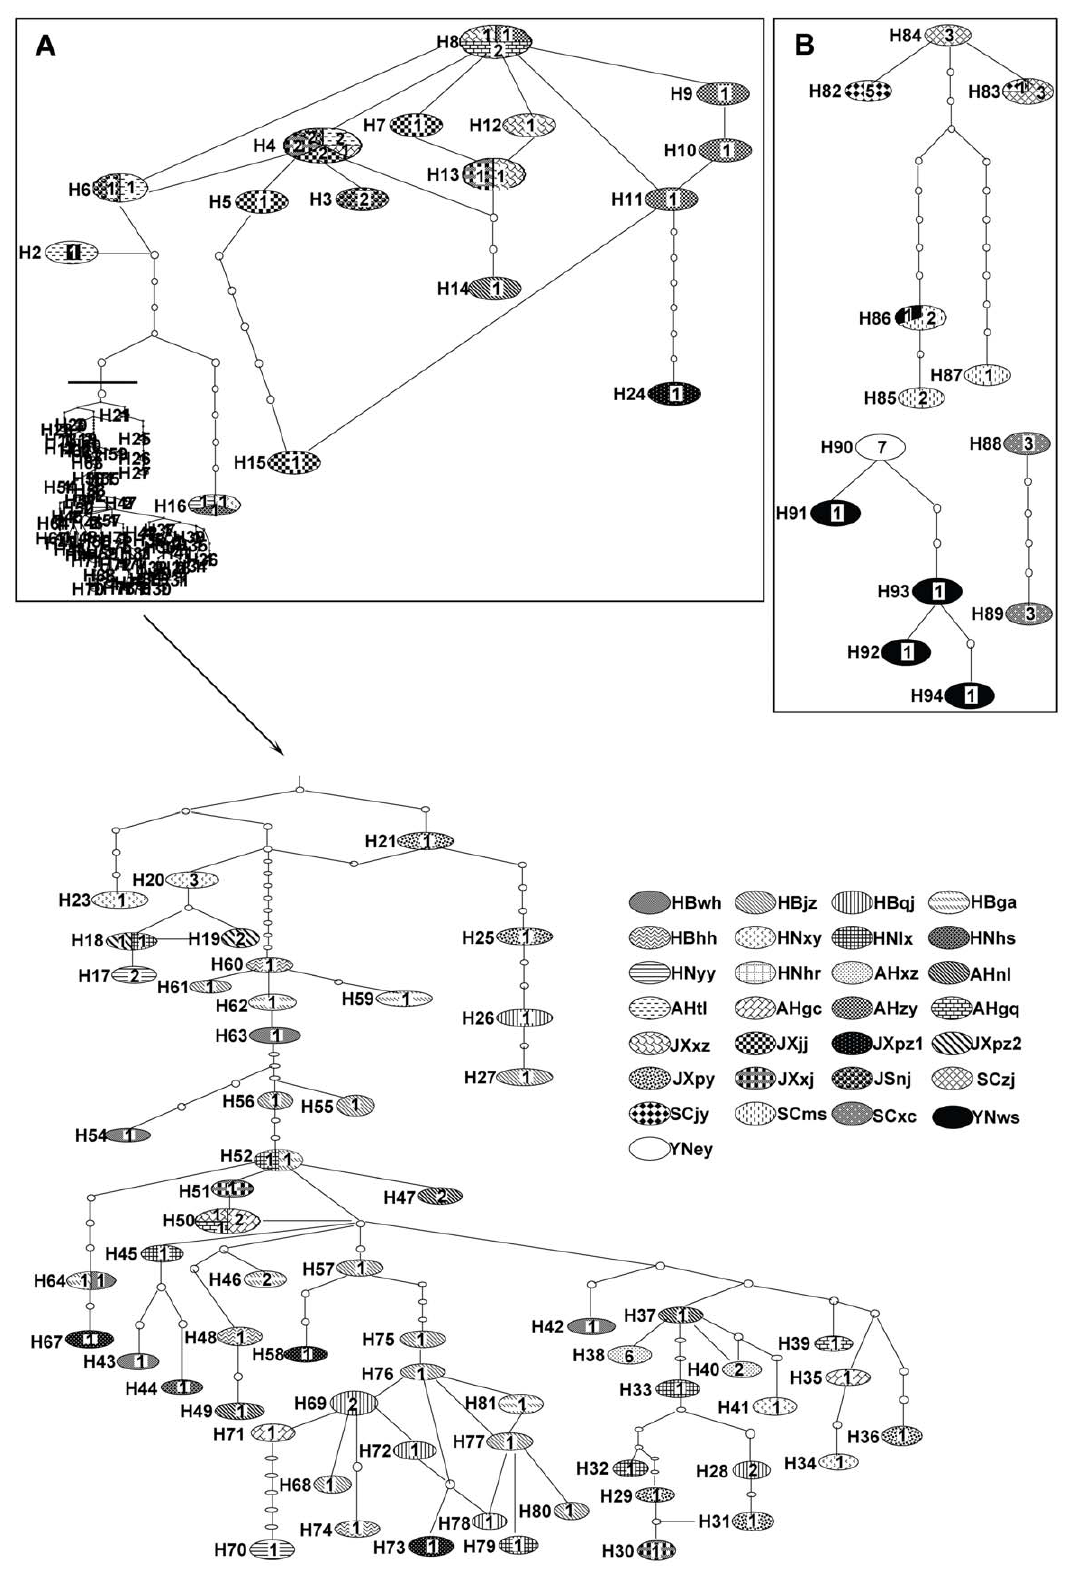
Figure 4. Unrooted parsimony network of ITS–ITS2 sequence haplotypes for Oncomelaniahupensis . Ovals indicate sampled haplotypes, which have designated numbers beside them. Numbers inside ovals indicate sample numbers from different geographical populations which shared the same haplotype. Small circles indicate unsampled or extinct haplotypes. Each connection represents one mutational step. A and B (B1, B2 and B3) refer to the corresponding clades in Fig. 3, respectively. The branch under the dark line in clade A is expanded below, as indicated by the arrow.